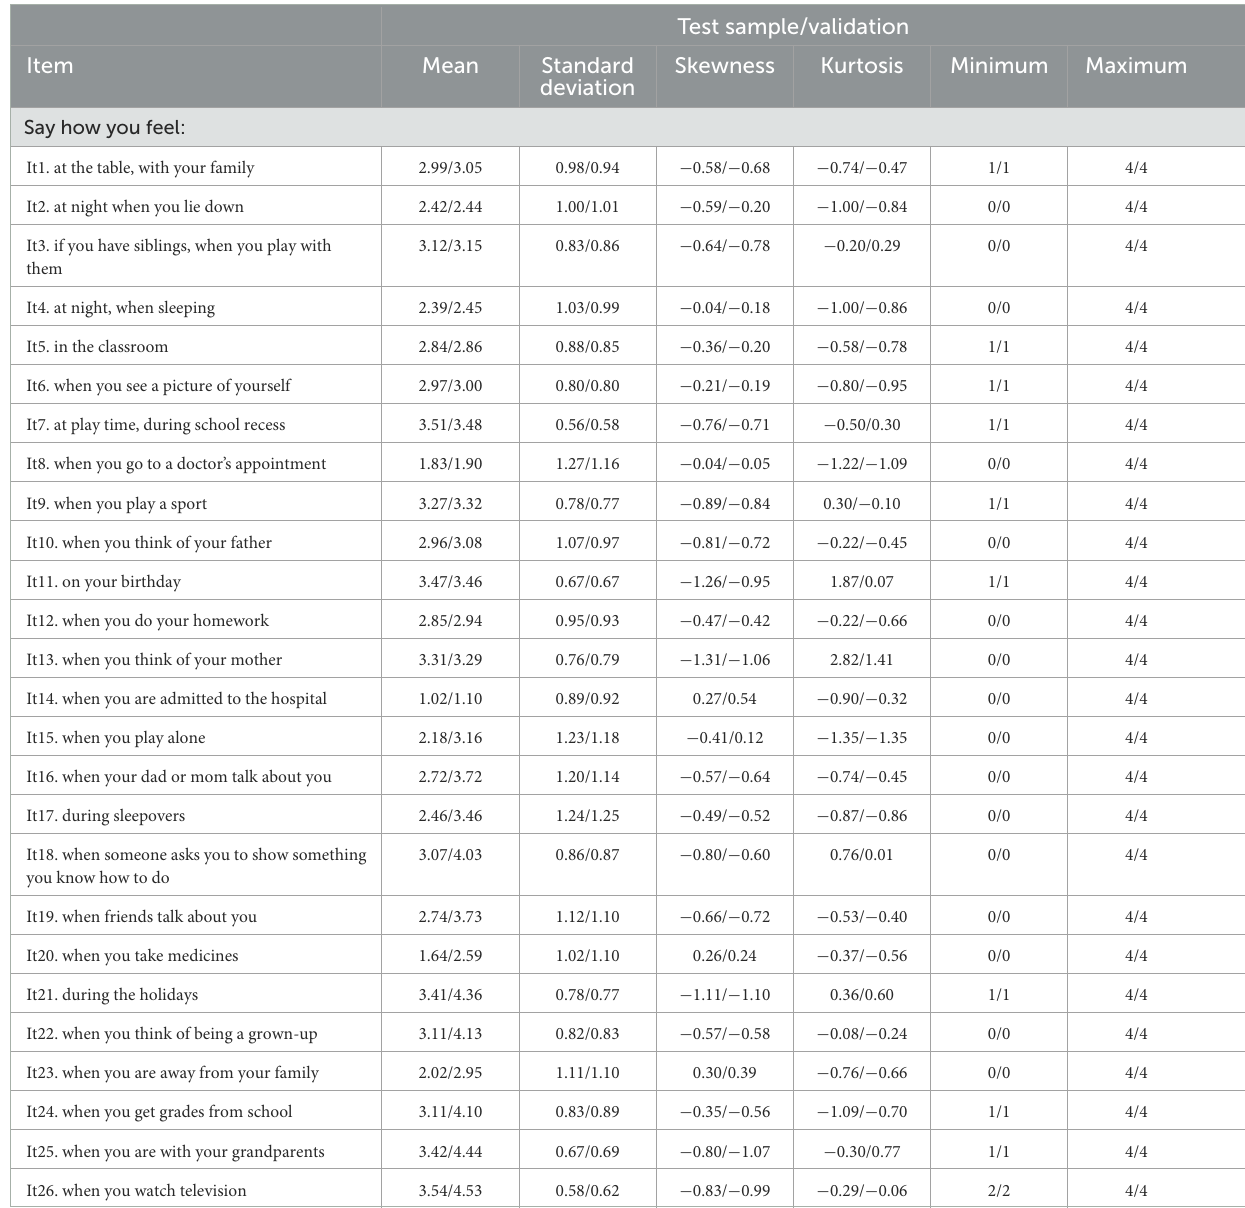
TABLE 2 Descriptive statistics of the Autoquestionnaire Qualité de Vie Enfant Imagé (AUQEI) responses by the participants (test sample N = 212 and validation sample N = 231).